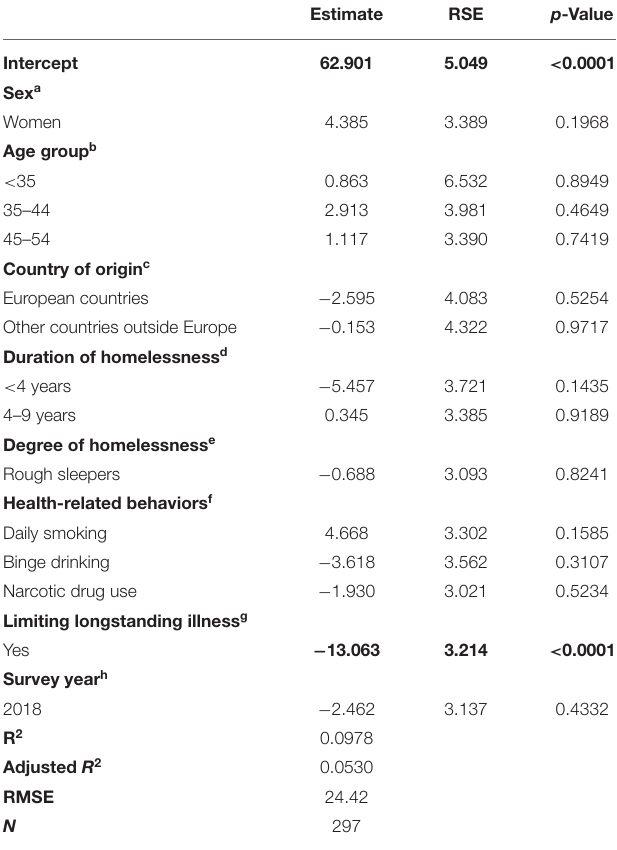
TABLE 5 | Ordinary Least Squares (OLS) regression on mean observed EQ VAS score adjusted for sex, age group, country of origin, duration of homelessness, degree of homelessness, health-related behaviors, limiting longstanding illness, and survey year, homeless people in 2006 and 2018,